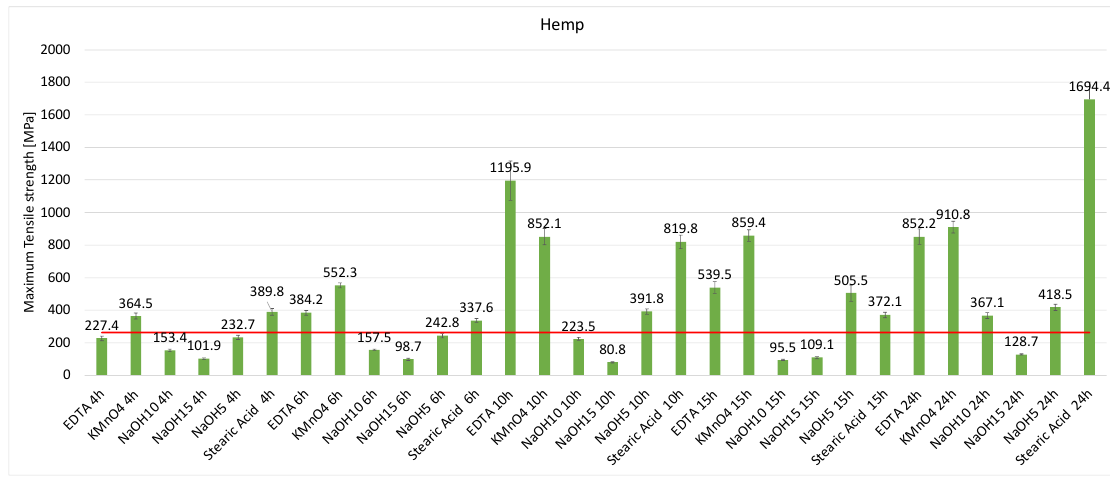
Figure 10. Maximum tensile strength obtained for each treatment on hemp fibres.